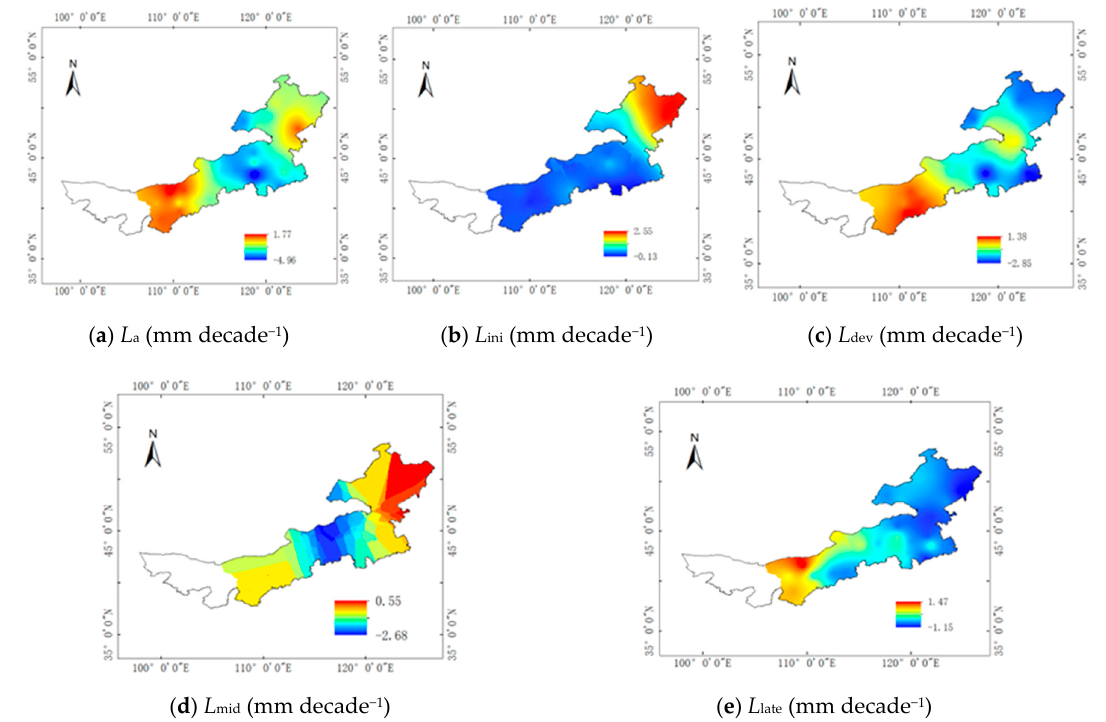
Figure 4. Spatial variation characteristics of P e slope during the entire growth period ( a ), early growth period ( b ), rapid growth period ( c ), middle growth period ( d ), and end growth period ( e ) of maize from 1959 to 2018.